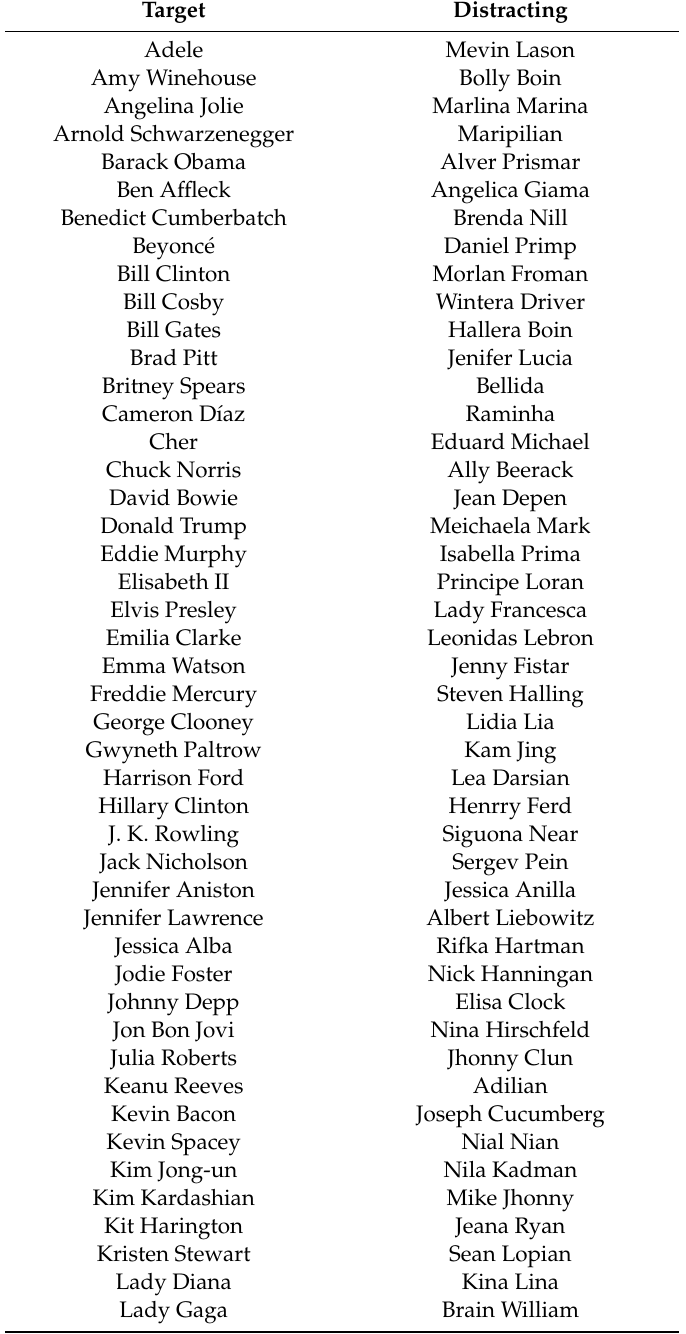
Table A1. Stimuli for Experiment 1 and